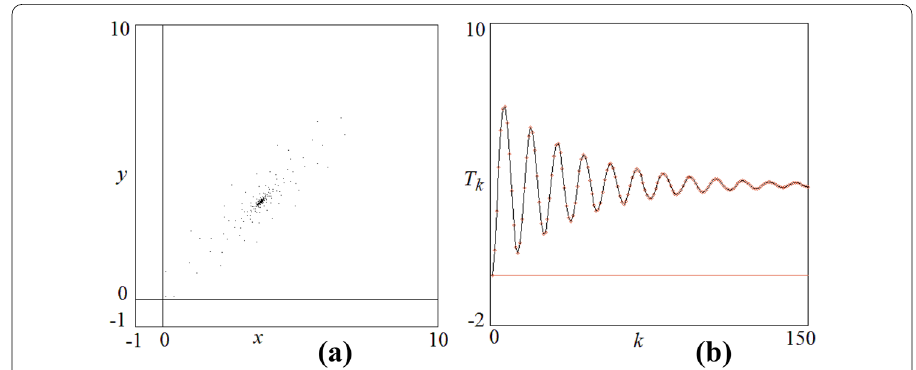
( T k , T k 1 ) for b = 1.5 , = +